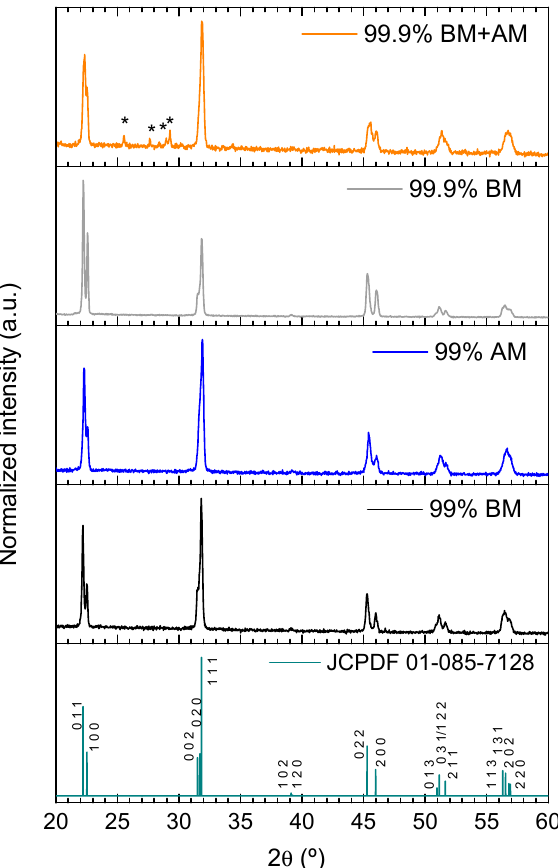
Figure 5. XRD patterns of FLASH-sintered ceramics. JCPDF file #01-085-7128 of orthorhombic K 0.5 Na 0.5 NbO 3 is shown for comparison. Nb-rich secondary phases are identified with * for 99.9% BM+AM ceramic.